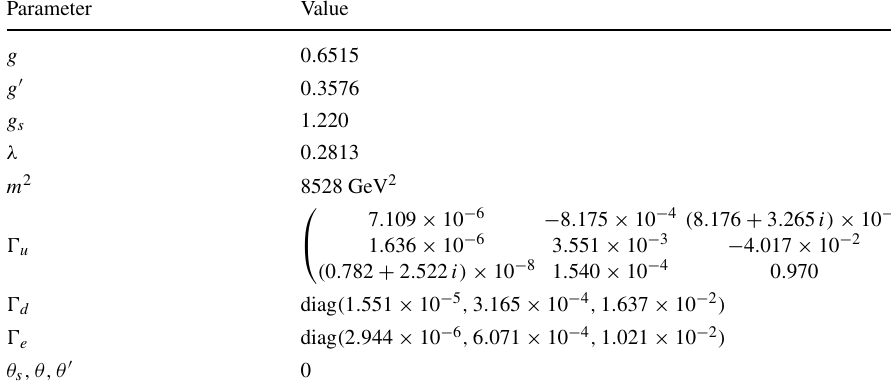
Table 1 Default DsixTools inputs for the SM parameters, taken in the MS scheme at the renormalization scale M Z = 91 . 1876 GeV. See